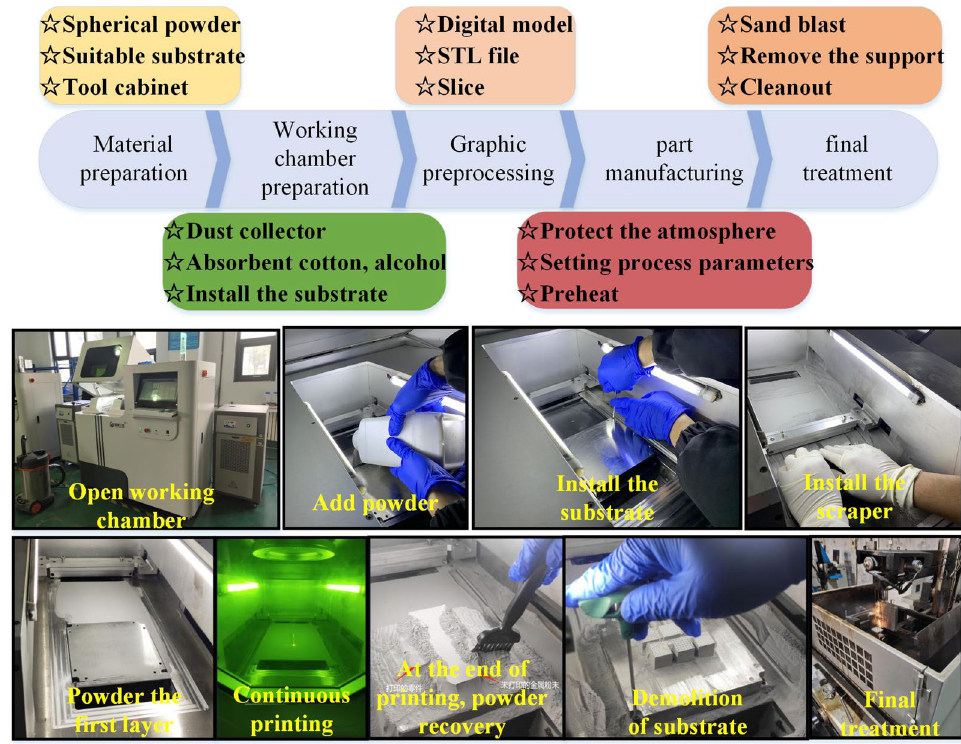
Figure 3 Metal printing process in laser selective melting